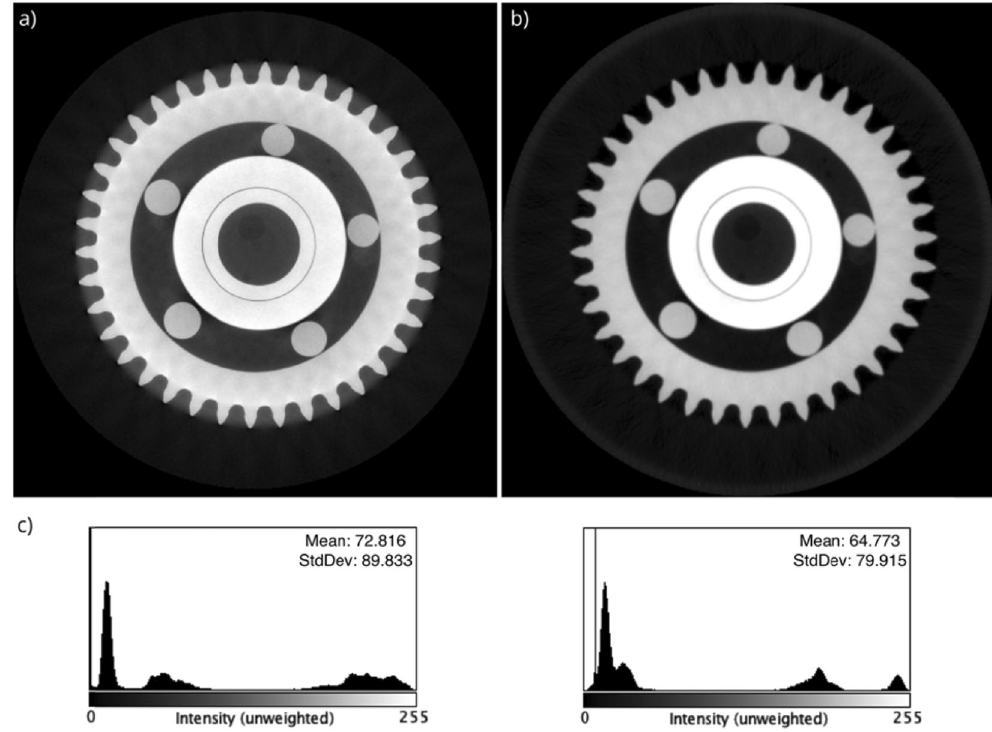
Figure 2. The reconstruction results of the ball bearing sample. Both images are reconstructed with the FDK algorithm using 3200 projections with 2048 × 2048 pixels. The voxel size of the reconstructed images is 3.7 µ m. ( a ) commercial reconstruction software, ( b ) customized reconstruction software, and ( c ) respective histograms of reconstructed images.